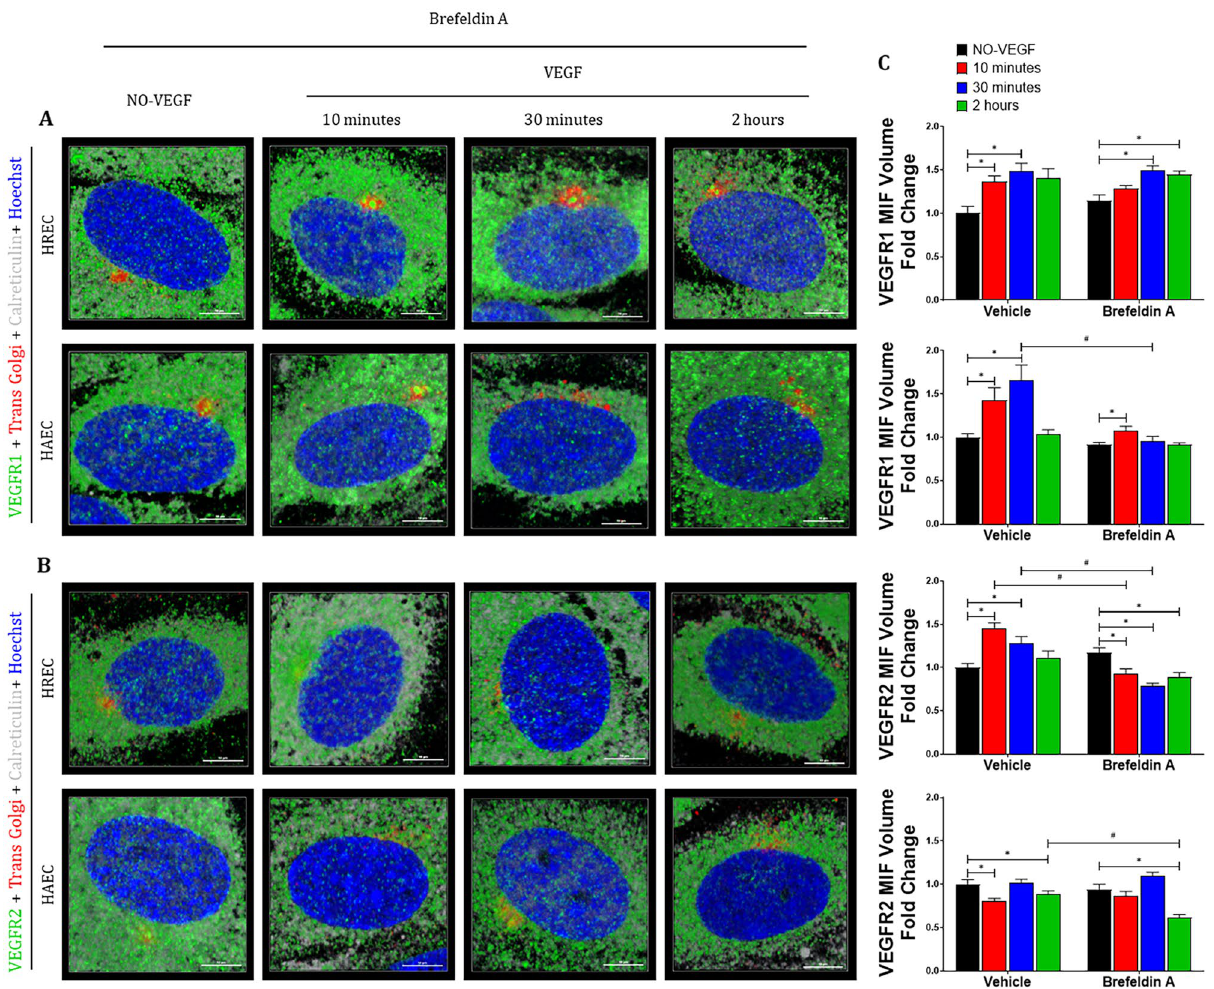
Figure 7. Depletion of the biosynthetic pool by Brefeldin A prevents nuclear translocation of VEGFR2 into VEGF-stimulated microvascular endothelial cells . Intracellular trafficking of VEGFR1 and VEGFR2 in HREC and HAEC was evaluated by immunofluorescence at different time points (10 min, 30 min and 2 h) after exposure to 100 ng/ml VEGF and compared to saline controls (NO-VEGF). Triple immunofluorescence was performed to confirm the biosynthetic pool depletion after Brefeldin A treatment and evaluate the nuclear translocation of the VEGFRs by measuring the MIF. ( A–B ) 3D reconstruction rendering of the HREC and HAEC immunostained with VEGFR1 and VEGFR2 (green), respectively, plus trans Golgi (red), calreticulin (endoplasmic reticulum-ER gray) and DNA intercalating dye Hoechst (nuclei-blue). The colocalization points between green and red are shown in yellow and between green and gray shown in cyan. Scale bars = 10 μm. ( C ) Graphs showing the quantification of the median intensity of fluorescence (MIF) volume of at least 10 confocal z-stack images at 400 × magnification for each experiment performed using NIS elements software. MIF graphs represent VEGF time point fold change with respect to control vehicle treated NO-VEGF and the graphs bars represents the average of the a minimum of 3 separate experiments from HREC and HAEC. The results show that the nuclear translocating pool of the VEGFR2 in HREC are derived from the Golgi. * = p < 0.05 as determined by 2-way ANOVA followed by multi-comparison post-hoc Tukey’s test shows intra-group differences with respect to the VEGF treatment and # = p < 0.05 2-way ANOVA followed by multi-comparison post-hoc Tukey’s and t-student tests shows inter-group differences with respect to the Vehicle and Brefeldin A inversely reciprocal pattern of VEGFR1 and VEGFR2 regulation in tumor-associated and endothelial cells where VEGF-induced angiogenesis is regulated by an interaction between both receptors. Previously, we reported 25 that the VEGFR1:VEGFR2 ratio is important in maintaining the integrity of adherens junctions and coordinates vascular permeability. It should be noted that there was some donor-to-donor variation in the timing and extent of nuclear VEGFR translocation in the primary HREC cultures but in all cases VEGF stimulated nuclear trans- location of VEGFRs. Such donor variation between primary cultures is well documented 38–40 . Interestingly, whilst there are no significant temporal differences in nuclear translocation of the C- and N-terminal portions of VEGFR1 there was an 80% increase in the C-terminal staining for VEGFR1 compared to N-terminal staining. This would suggest that the nuclear translocation of VEGFR1 is primarily in a cleaved